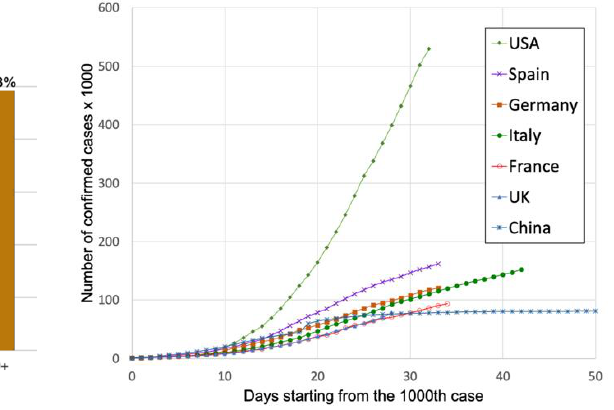
Figure 2. Number of confirmed cases aligned to the 1000th case